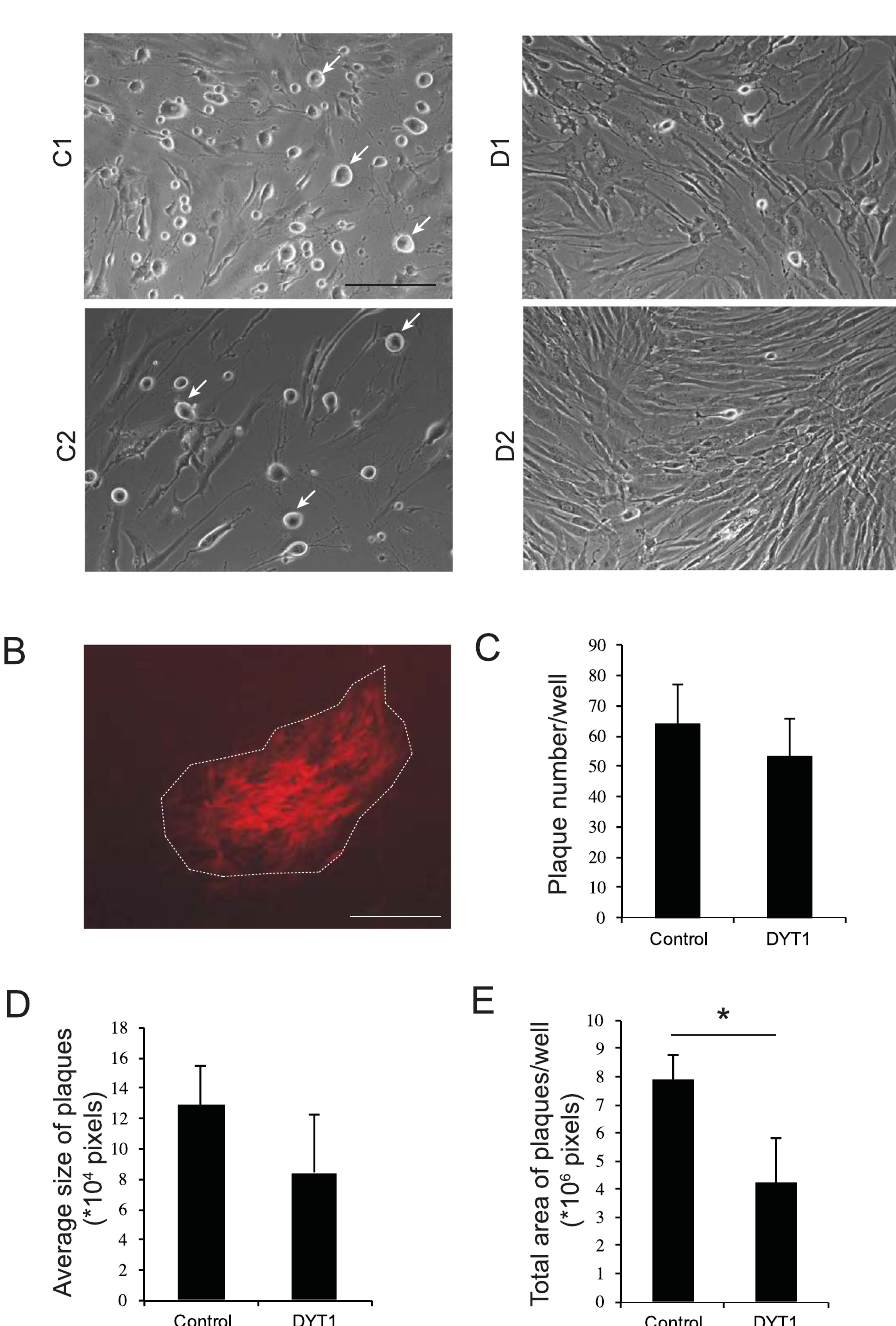
Figure 1. HSV replication dynamics in DYT1 and control fibroblasts. Human patient and control fibroblasts were infected with HSV-VP26-RFP and cytopathic effect and plaque formation were evaluated. ( A ) Cytopathic effect of the virus (M.O.I. 0.001) was more pronounced in two control lines (GM05659, C1; GM08424, C2) (rounded cells) than in two DYT1 patient derived lines (MIN30857, D1; D2306, D2) at 44 h post-infection (200x magnification, scale bar is 50 μ m). ( B ) An example of a red fluorescent viral plaque in GM08424 cells in the semisolid 0.4% agarose medium (40x magnification, scale bar is 250 μ m). The plaque number ( C ), plaque size ( D ) and total plaque area ( E ) was determined using ImageJ in DYT1 lines (n = 3, MIN30857 GM02306 and GM02551) and control lines (n = 3, GM05659, GM08424, NHF74). Experiments were always performed in pairs with one DYT1 and one control line. On average DYT1 cultures had significantly decreased total plaque area (plaque number x plaque size) as compared to control cultures (p < 0.033, paired t